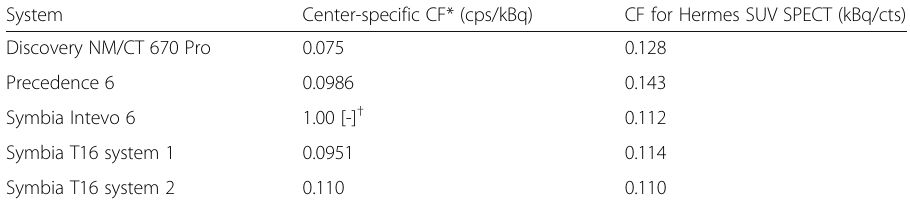
Table 4 Calibration factors for center-specific and vendor-neutral reconstructions, calculated for 128 projections and 20